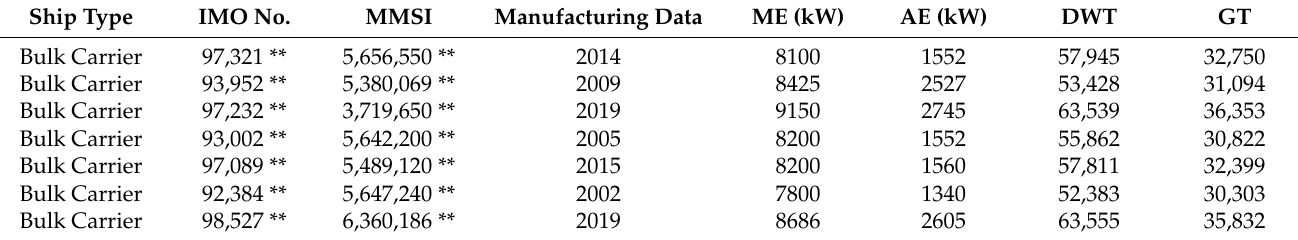
Table A1. Sample vessel profiles.